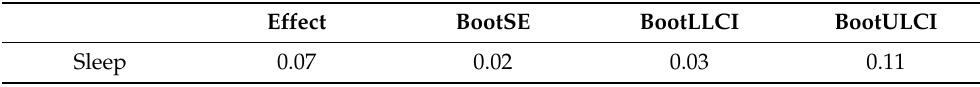
Table 8. Indirect effect of the secure base support from the father (SBS_F) on sleep quality.